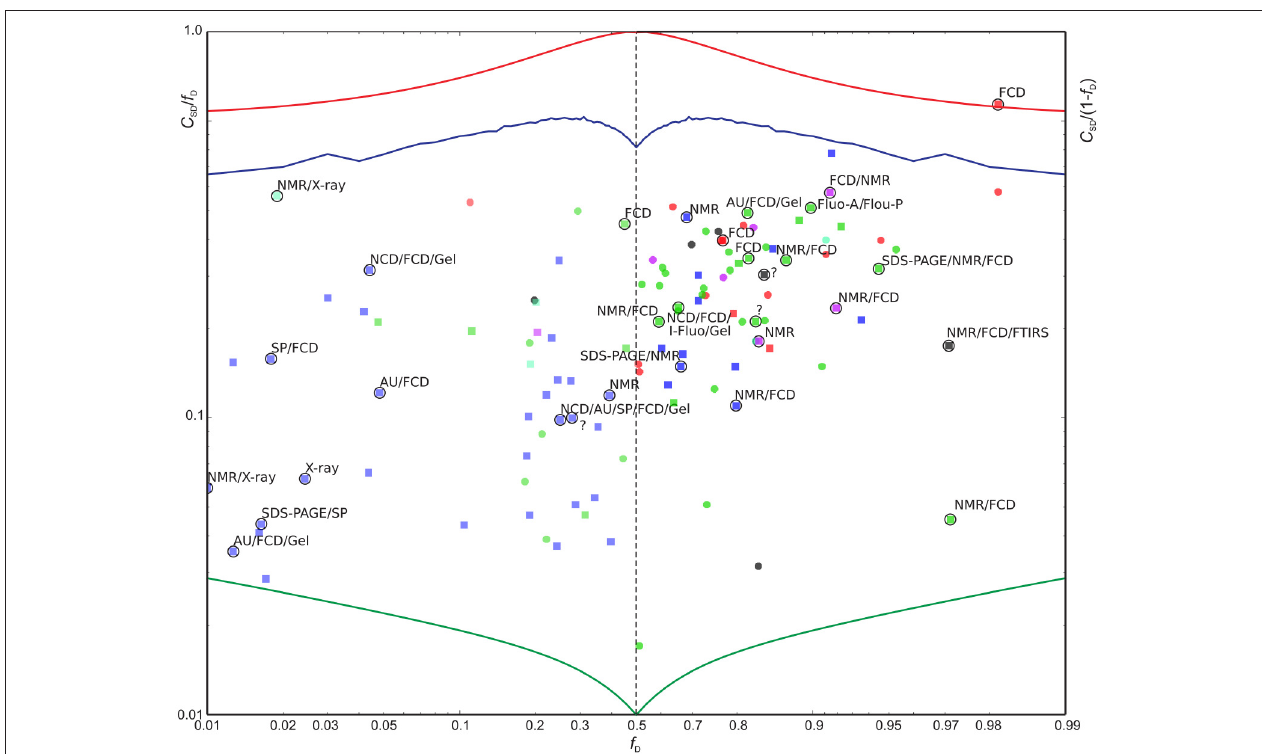
FIGURE 5 | Scaled sequence disorder complexity C SD / f D as function of f D (left) and C SD /(1 − f D ) vs. (1 − f D ) (right). Extreme values are shown for reference: The minimum possible C SD for a protein of length L = 200 (green), the maximum C SD (L = 200) (red), and C SD for randomly distributed outcomes with a probability f D for a disordered residue (blue). Entries highlighted with circles were also found in the DisProt database with confirmed > 90% sequence identity relative to the BRMB database amino acid sequence and with 90% of the aligned residues classified as disordered in DisProt (31 entries). See Figure 4 above for color-coding. The proteins found by searching the DisProt database are shown as squares. The methods used by the DisProt depositors for assessing disorder are provided as annotations near the highlighting circles for the 31 validated entries above. An “?” indicates that no method was given. The following abbreviations were used: AU, Analytical ultracentrifugation; DLS, Dynamic light scattering; EMSA, Electrophoretic Mobility Shift Assay; FCD, Circular dichroism (CD) spectroscopy, far-UV; Fluo-A/Flou-P, Fluorescence polarization/anisotropy; FTIRS, Fourier transform infrared spectroscopy; Gel, Size exclusion/gel filtration chromatography; I-Fluo, Fluorescence, intrinsic; SAXS, Small-angle X-ray scattering (SAXS); SDS-PAGE, Polyacrylamide gel electrophoresis in sodium dodecyl sulfate; SP, Sensitivity to